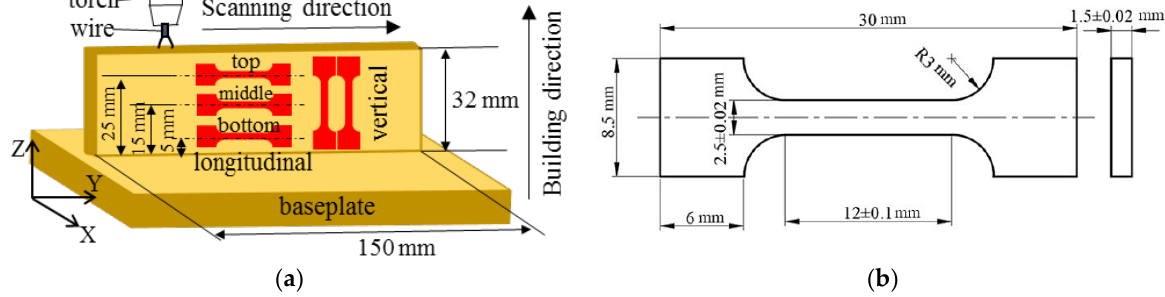
Figure 3. Position and dimension of tensile samples: ( a ) sample position within the additive manufacturing (AM) part (Y and Z denote the scanning direction and building direction, respectively); ( b ) detailed dimension of the tensile sample.